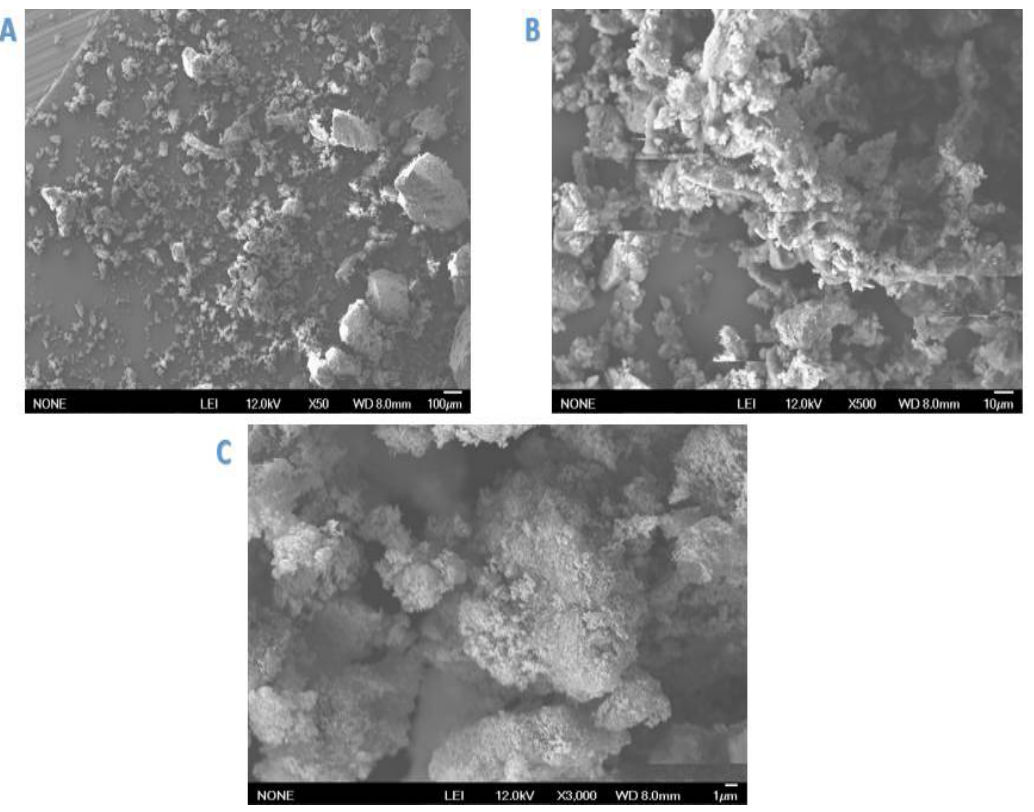
Figure 3. SEM analysis of Cell-D at three different magnifications: ( A ): 100, ( B) : 10, & ( C ): 1 µm. The obtained SEM images of Cell-X show a porous structure, with high surface. These characteristics contribute to the high adsorbent efficiency of the polymer. In addition, SEM analysis of Cell-D (Figure 3), shows almost similar morphology to that detected for Cell- X.